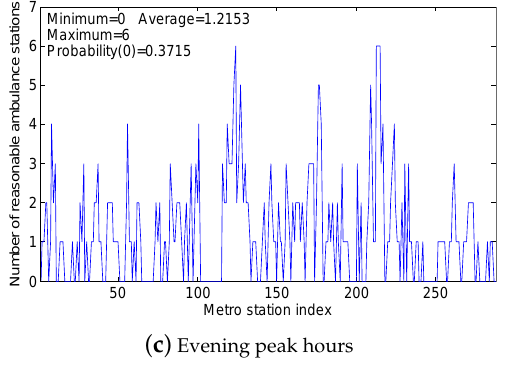
Figure 3. Distribution of number of available ambulance